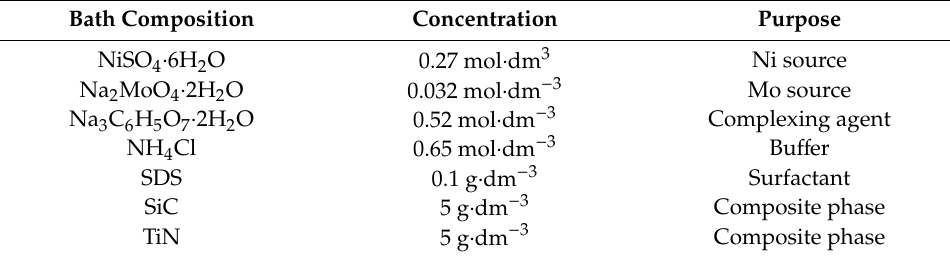
Table 1. Components of the electrolyte for the electrodeposition of the Ni–Mo–SiC–TiN coating. Bath Composition